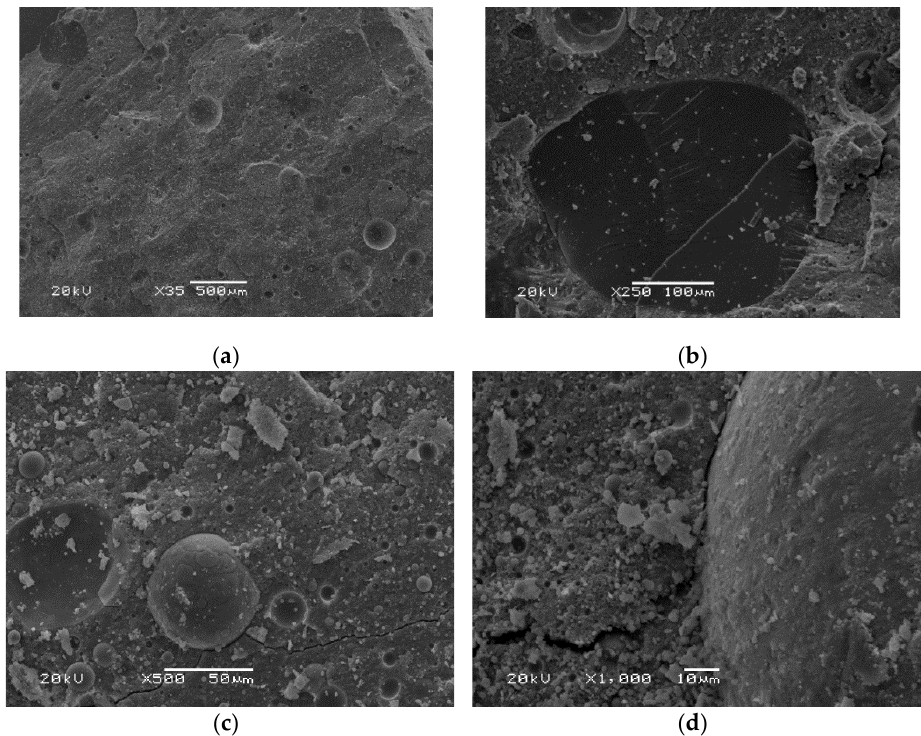
Figure 8. SEM pictures of materials based on ultra-fine fly ash—RUFA (R) in magnification: ( a ) 35×; ( b ) 250×; ( c ) 500×; ( d ) 1000×. Observations of the microstructure of the material made from ultra-fine fly ash, RUFA (Figure 8), showed an equally compact and amorphous structure of the material.